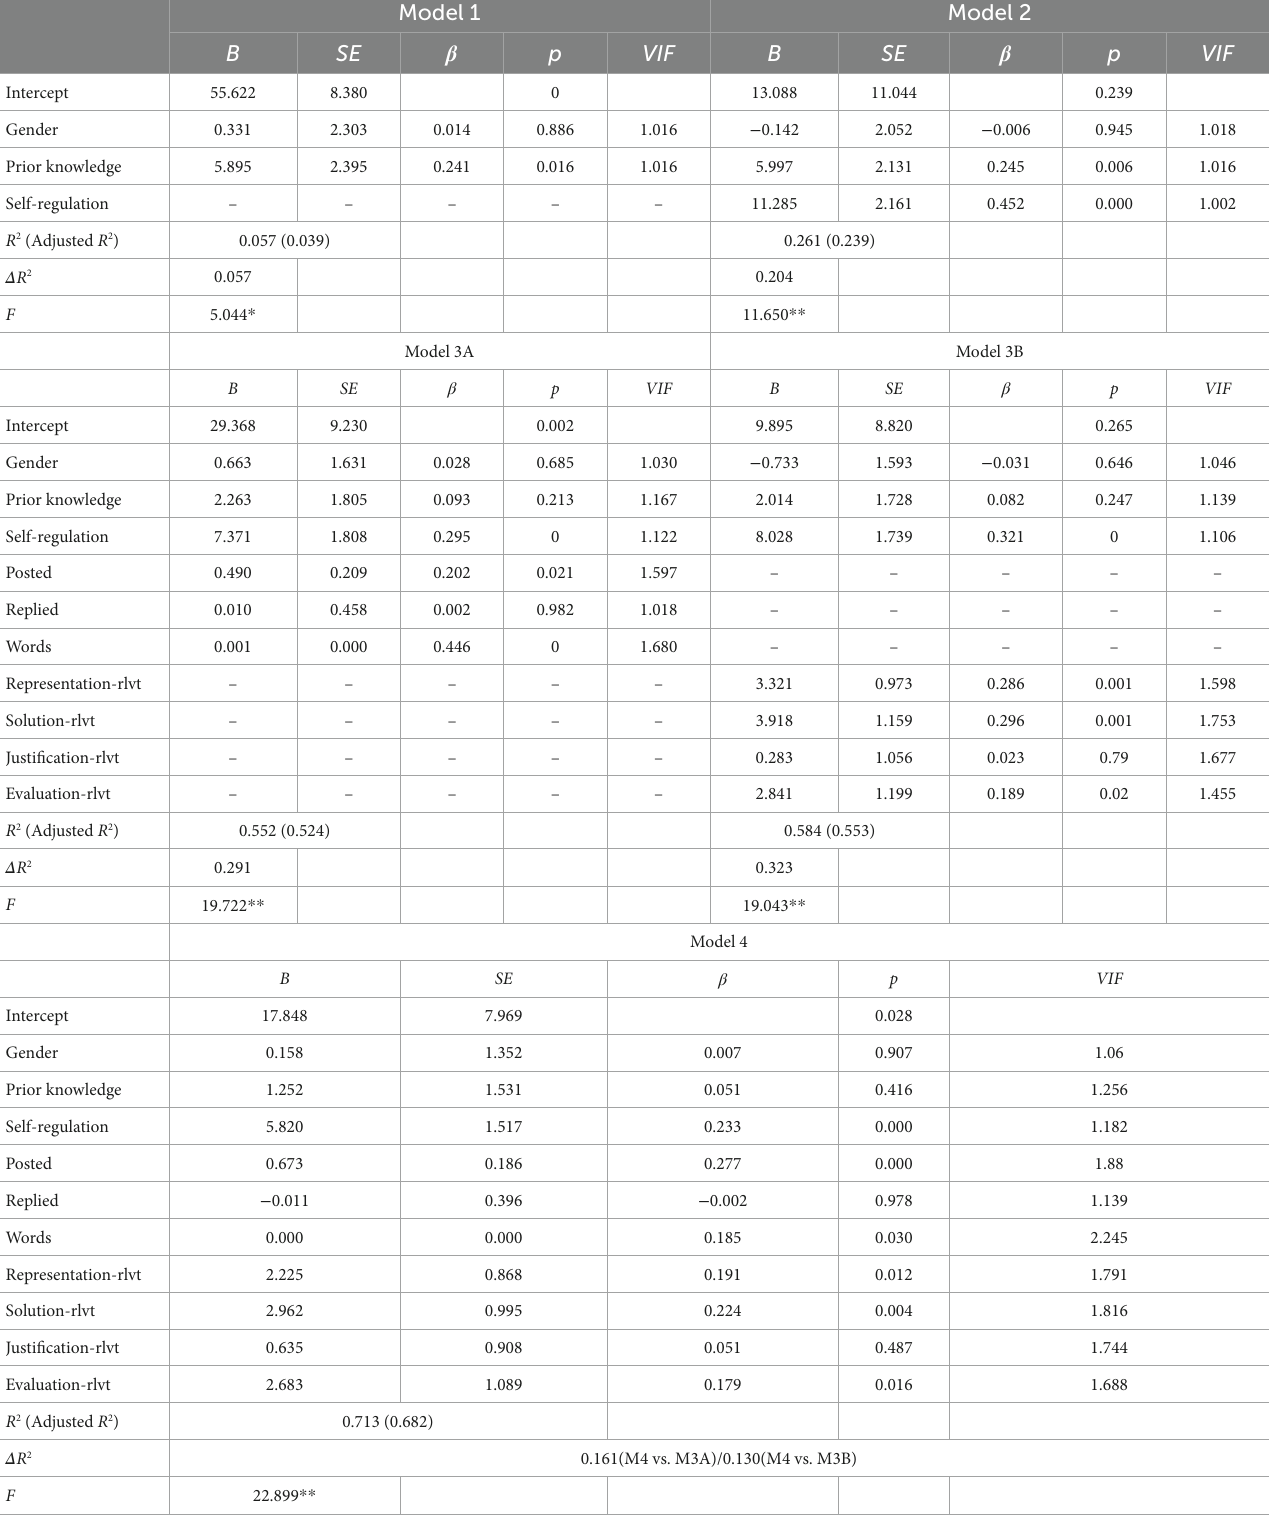
TABLE 3 Hierarchical linear regression analysis to predict PBL